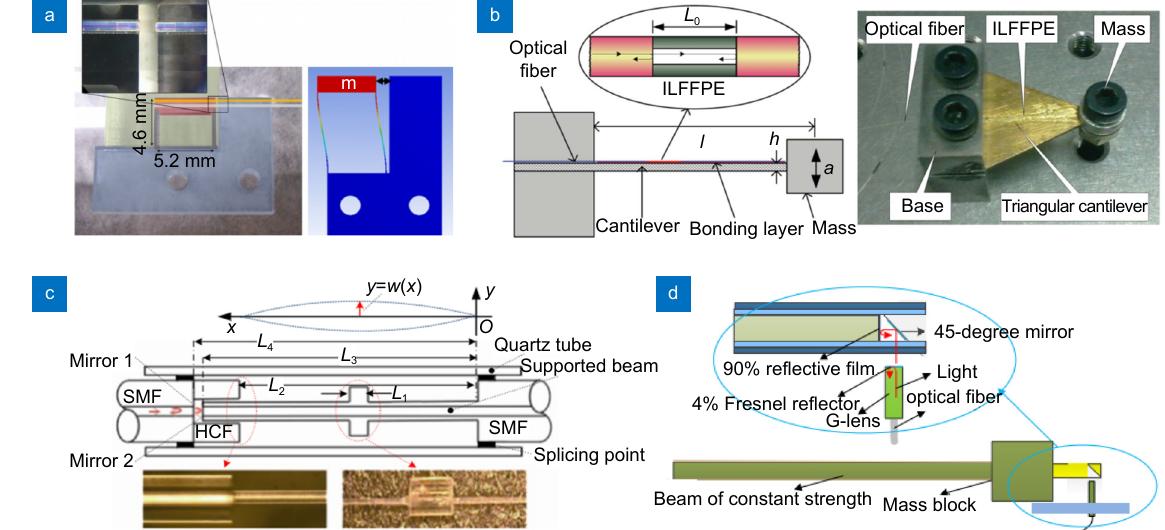
Fig. 22 | ( a ) Photograph and sketch of a Fabry-Perot accelerometer. ( b ) Structural configuration and photograph of a Fabry-Perot cavity based accelerometer. ( c ) Simplified model of an all-optical fiber vibration sensor. ( d ) A 45° Fabry-Perot interferometric cavity based accelerometer. Fig- ures reproduced with permission from: (a) ref. 103 , AIP Publishing; (b) ref. 130 , IEEE; (c) ref. 120 , Optical Society of America; (d) ref. 108 ,